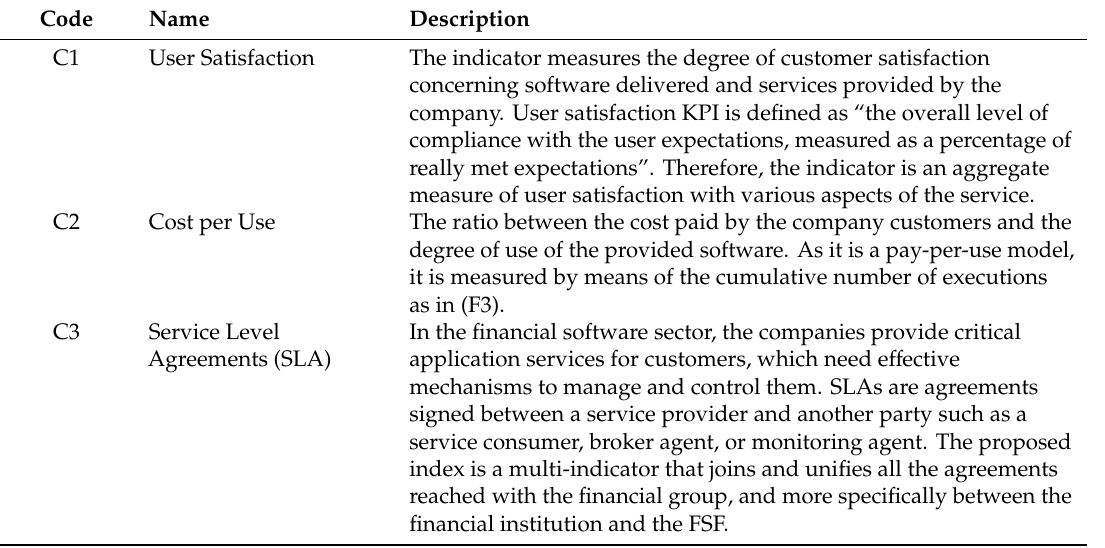
Table 2. Summary of the customer perspective key performance indicators.